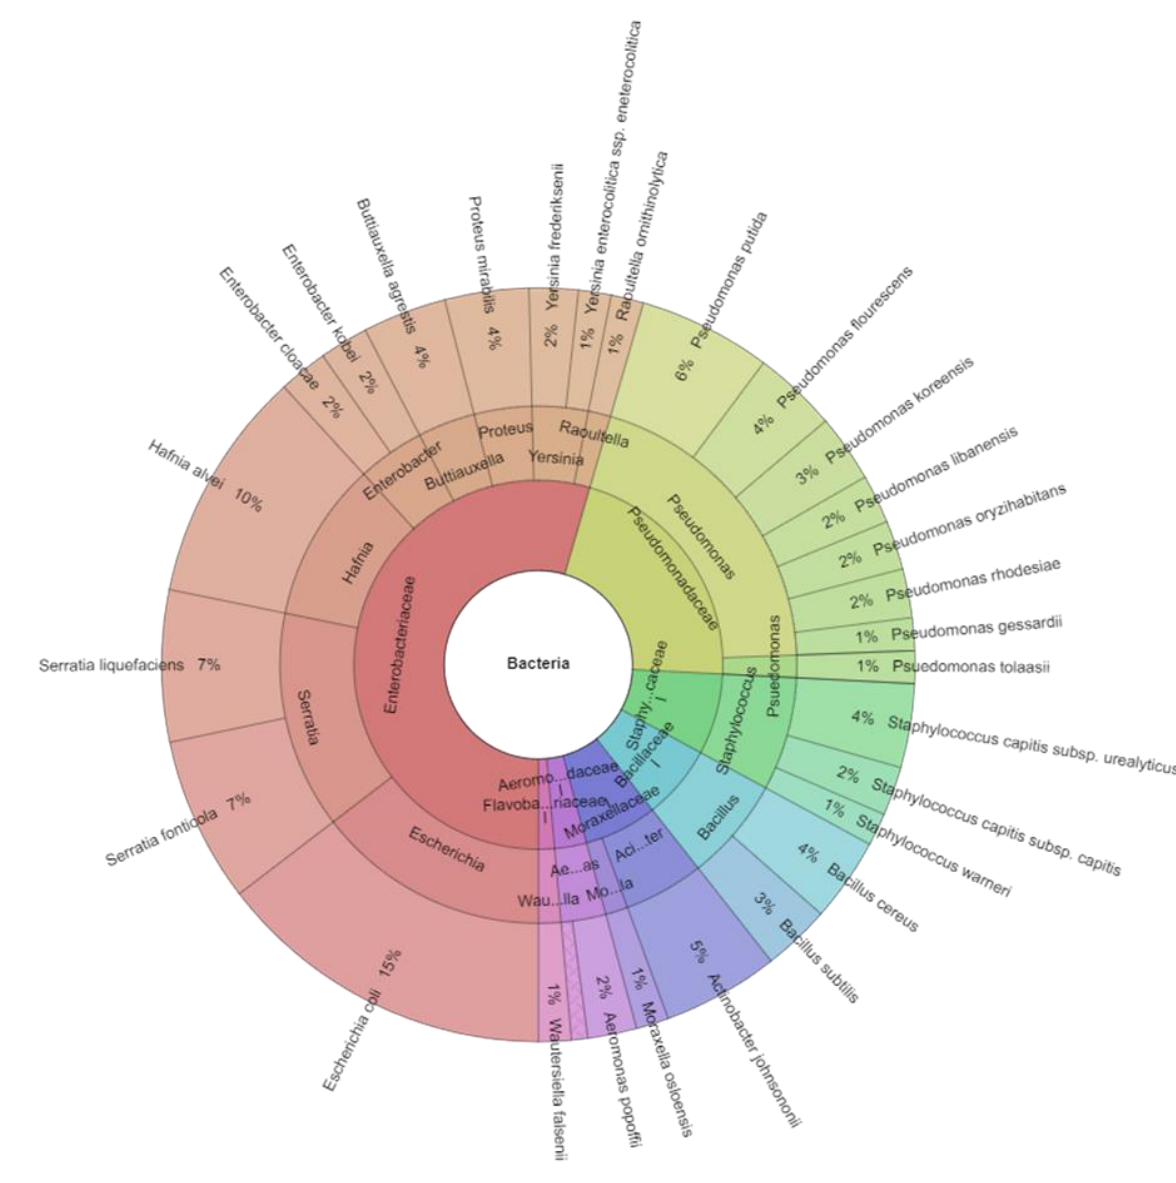
Figure 3. Krona chart: Isolated species of bacteria from raw and roasted chicken’s meat.